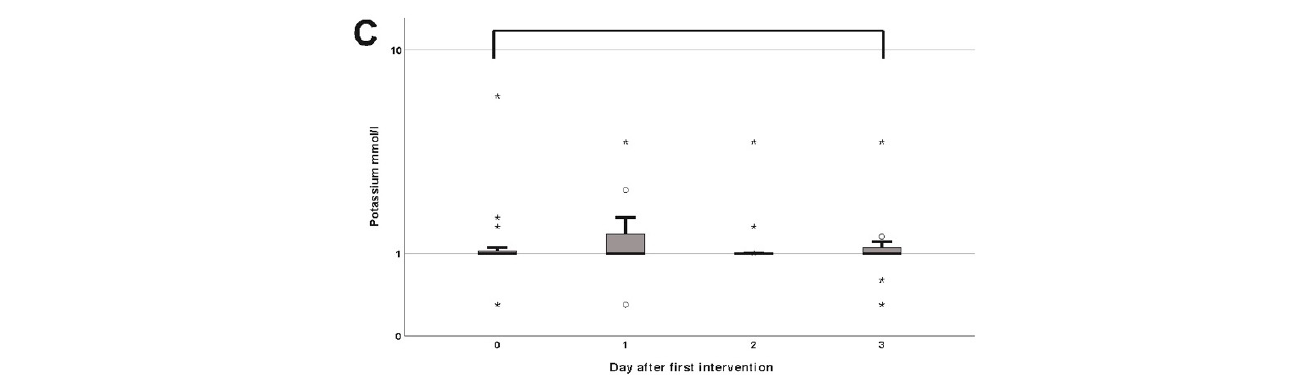
Figure 2. Boxplots of the pH-value ( A ), potassium (mmol/L) ( C ) and total protein (µg/mL) ( B ) on the day of the operation (0.) and first to third postoperative day. Stars and circles indicate extreme values exceeding the 95% confidence interval. The asterisk (*) indicates significance.